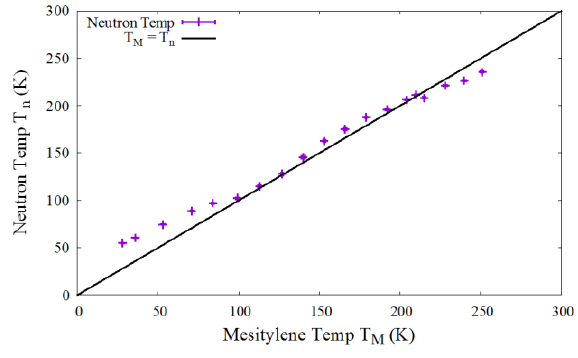
Fig. 6. The relation between T M and T n . In the figure, the solid line stands for the relation T M = T n . When T M >100K, T n changes along T M , which means that the neutron temperature follows the mesitylene